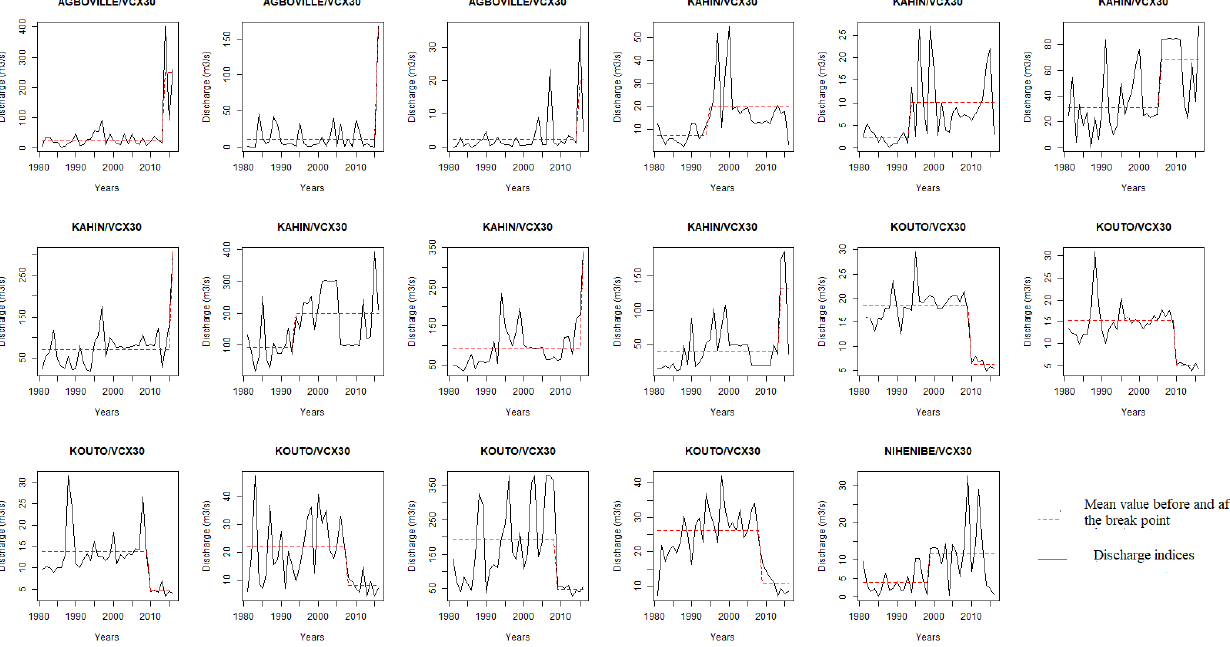
Figure A2. Homogeneous period for the trend analysis.